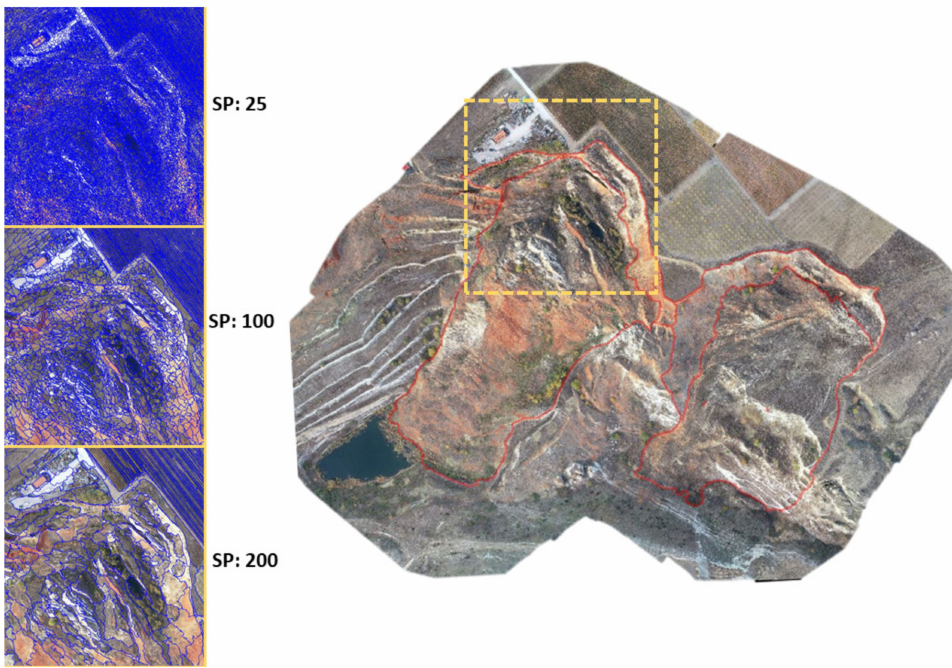
Figure 6. Selected subset of the area under investigation showing the segmentation results for different scale parame- ters (SPs).